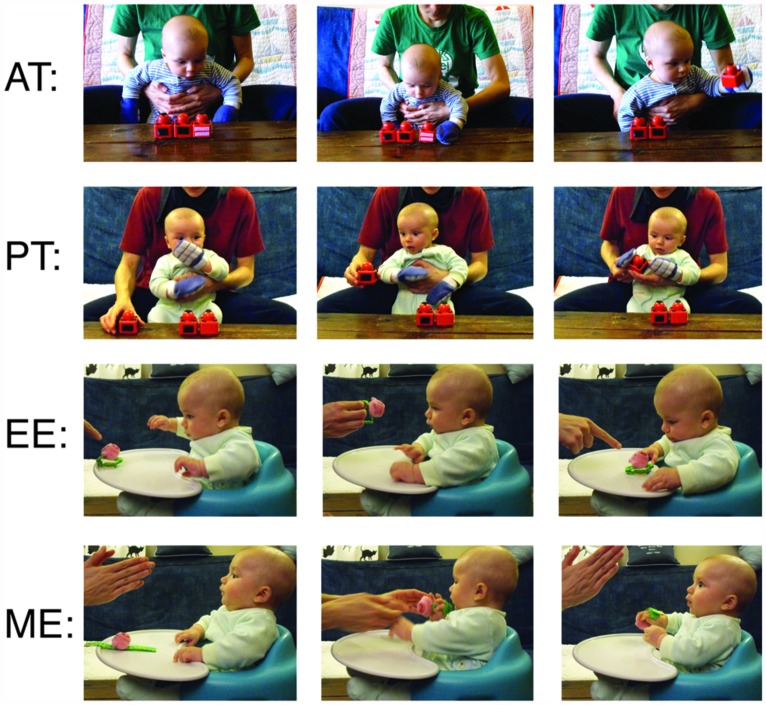
Example of training procedures. Active training (AT) – Infants wear “sticky mittens” allowing them to independently pick-up Velcro-covered toys. Passive training (PT) – Infants wear mittens without Velcro, parents lift and touch toy to infant’s palm. Encouragement experience (EE) – Parent draws attention to a small toy within reach of the infant, but does not help infant grasp toy. Movement experience (ME) – Parent engages infant but does not talk about or draw attention to toy, parent attached toy to infant’s hand without drawing attention to toy. Figure adapted from Libertus and Needham (2010, 2014).